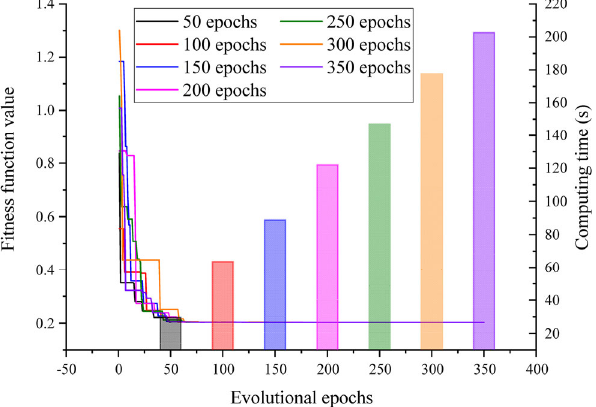
Fig. 14 Effect of different evolution epochs on the convergence of fitness function.